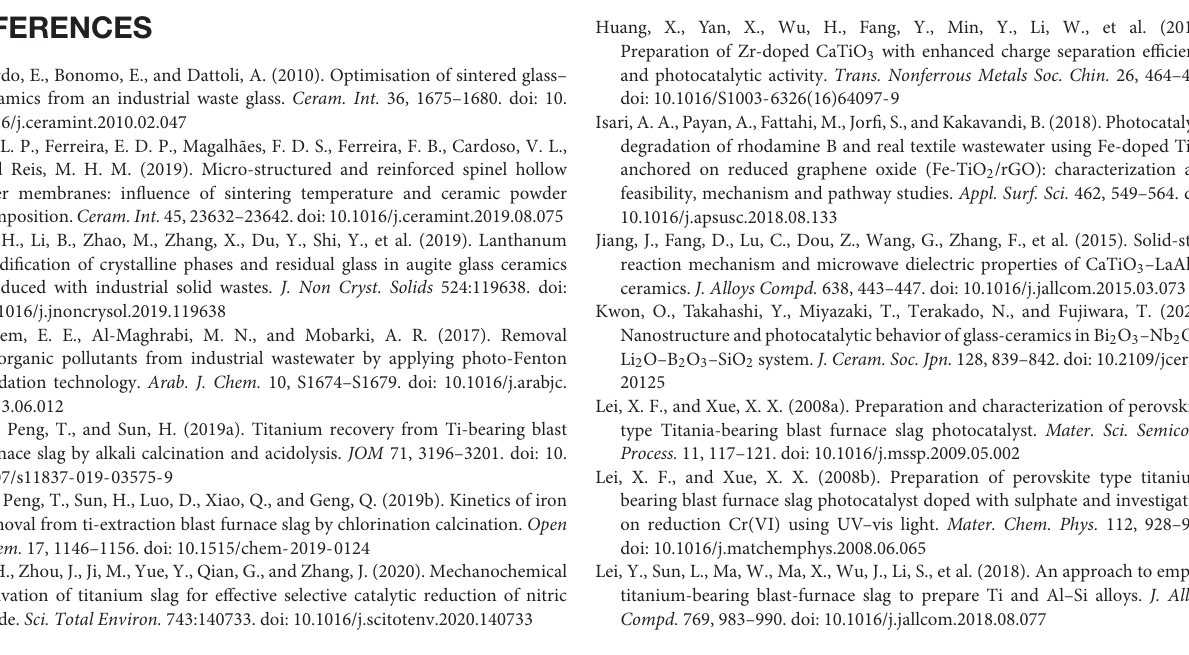
Supplementary Figure 1 | Energy dispersive spectrometer mappings of the EBFS-1180 ceramic. Supplementary Figure 2 | UV–vis absorption spectra of photocatalytic degradation of RhB by EBFS-1180